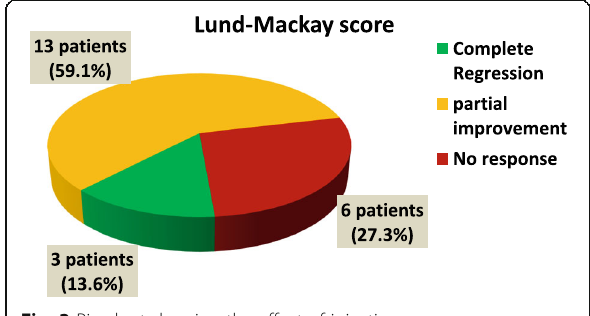
Fig. 1 Pie chart showing the effect of injection on total nasal polyps score (TNPS)